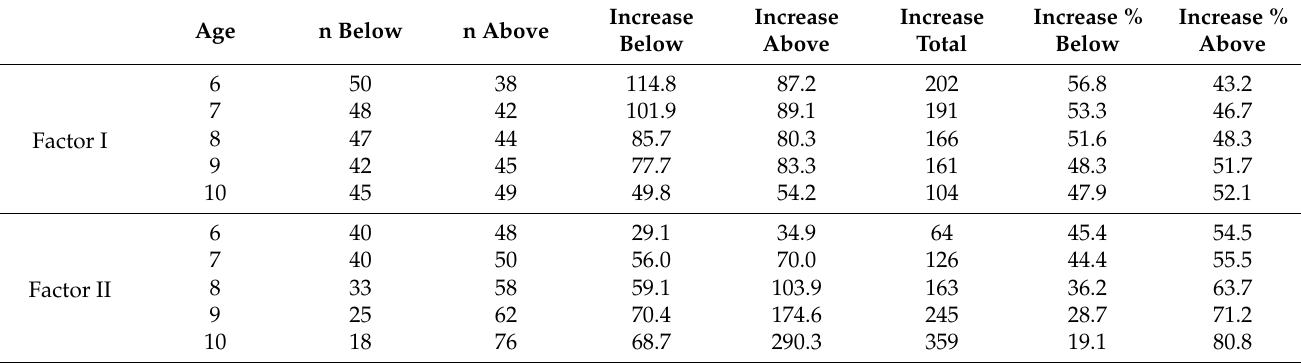
Table 6. Factor I and Factor II: increase after interview in subgroups below/above the mean perform- ers and in total